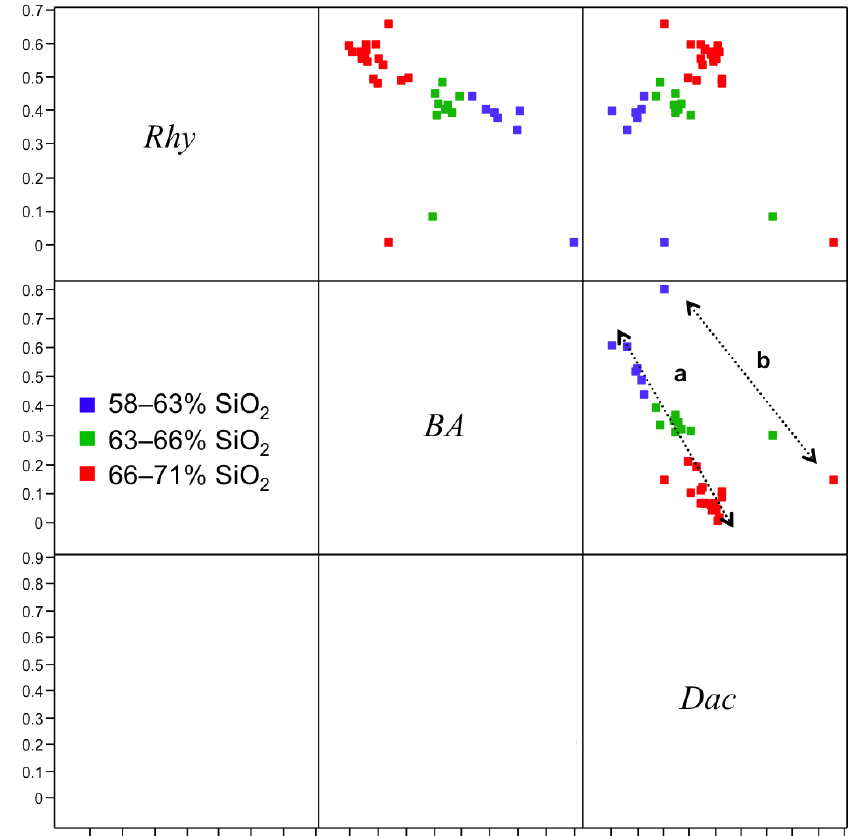
Figure 12. Scatter plot showing Papagayo samples in terms of relative proportions of the three end members identified by PVA. Samples are coded by the same arbitrary divisions in silica content as in previous diagrams. Two trends are identified among the samples and marked as trends “a” and “b” (see text for